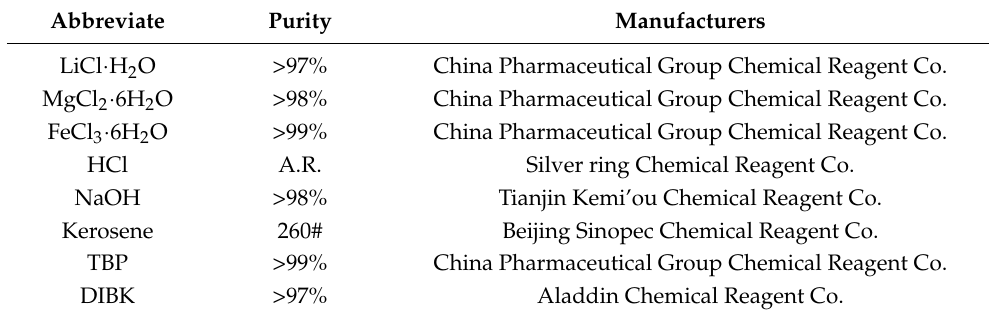
Table 1. Main chemical reagents.